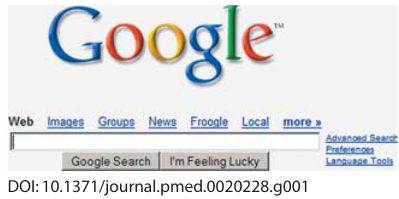
Figure 1. Google’s Home Page